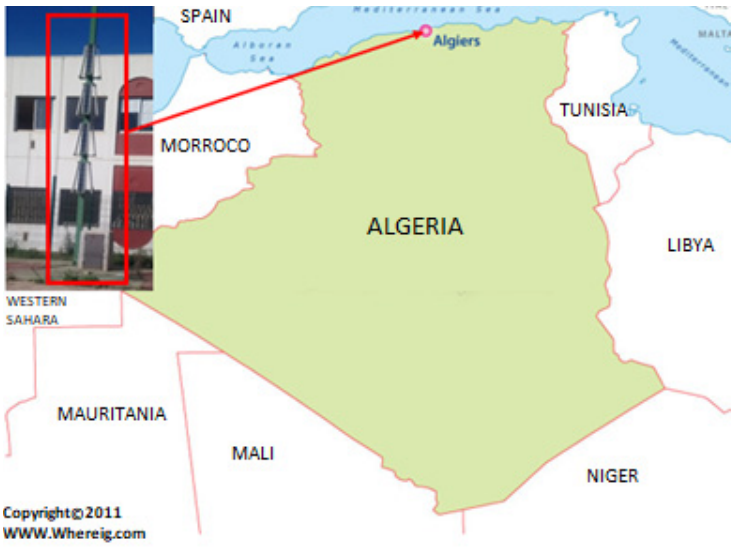
Figure 2. Geographical location of the proposed case study. Standalone solar-powered Wi-Fi built at ENST (Algiers, Algeria) [18].